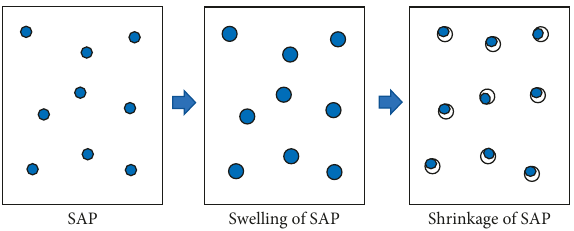
Figure 8: Schematic of the swelling and shrinkage of SAP.